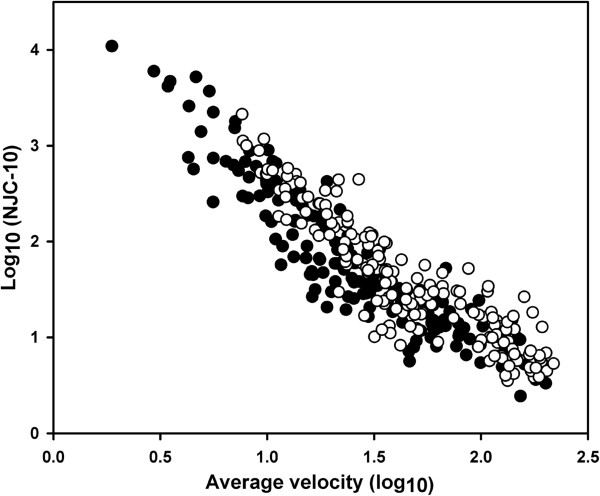
Relationship between average velocity (log
10
) and normalized jerk cost (NJC-10) (log
10
) across all speed conditions for all movement directions pooled for the WAD (filled circles, n = 15, 180 trials) and the control (open circles, n = 15, 180 trials) groups.